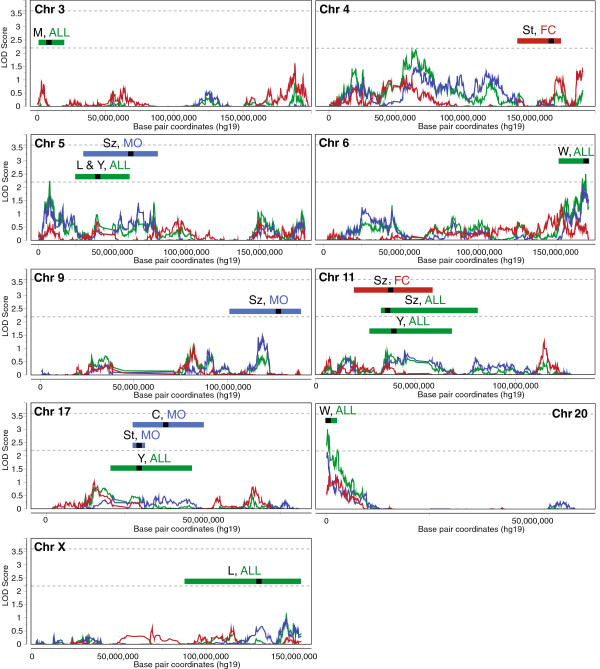
Linkage in regions of interest from previous studies: combined sample. Logarithm of odds (LOD) scores from non-parametric, multipoint linkage analysis for autism spectrum disorder affection status in the combined sample (Merlin) are plotted for chromosomes with suggestive linkage peaks (LOD ≥2.2) from previous studies. Colored bars and black marks indicate the spans and peaks of linkage regions of interest, respectively; text indicates the linkage region source (L, Liu et al., 2001 [26]; Y, Yonan et al., 2003 [34]; St, Stone et al., 2004 [28]; C, Cantor et al., 2005 [25]; M, McCauley et al., 2005 [27]; Sz, Szatmari et al., 2007 [32]; W, Weiss et al., 2009 [33]; green and ALL, all multiplex families; blue and MO, male-only families; red and FC, female-containing families). Dashed lines mark LOD thresholds of 2.2 for suggestive and 3.6 for significant linkage.